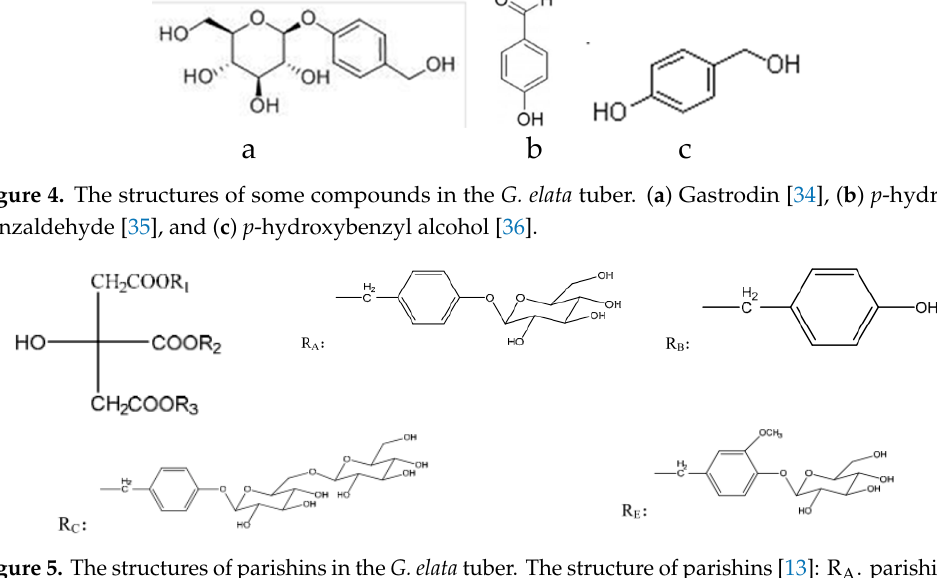
Figure 5. The structures of parishins in the G. elata tuber. The structure of parishins [13]: R A . parishin